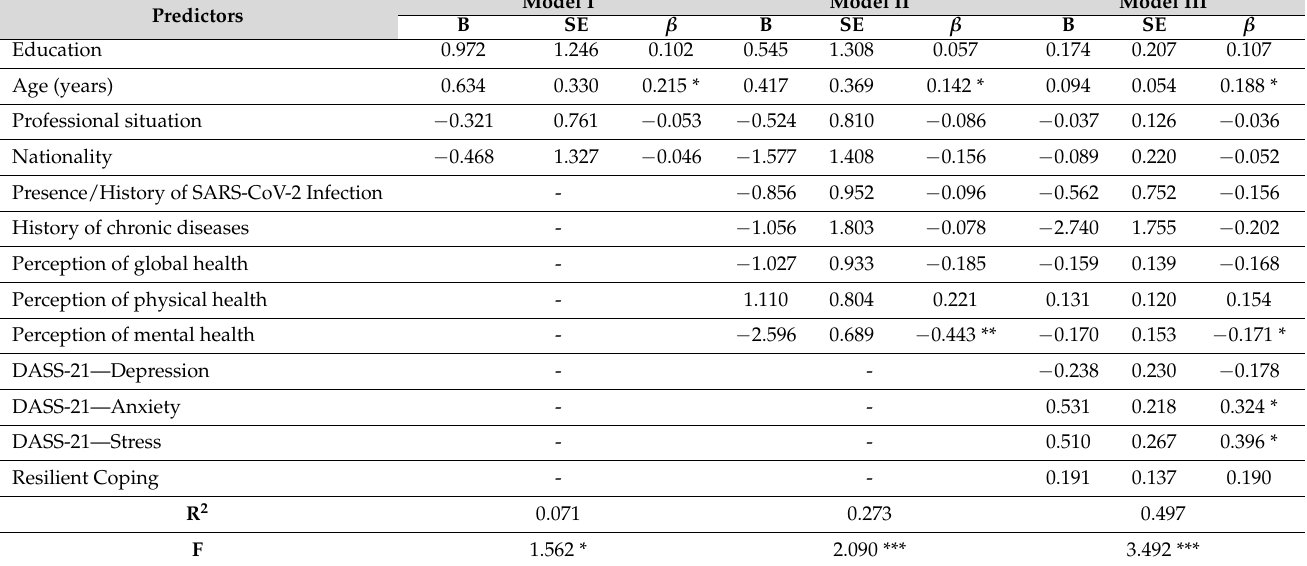
Table 4. Hierarchical multiple regression analysis predicting fear of COVID-19 (n =